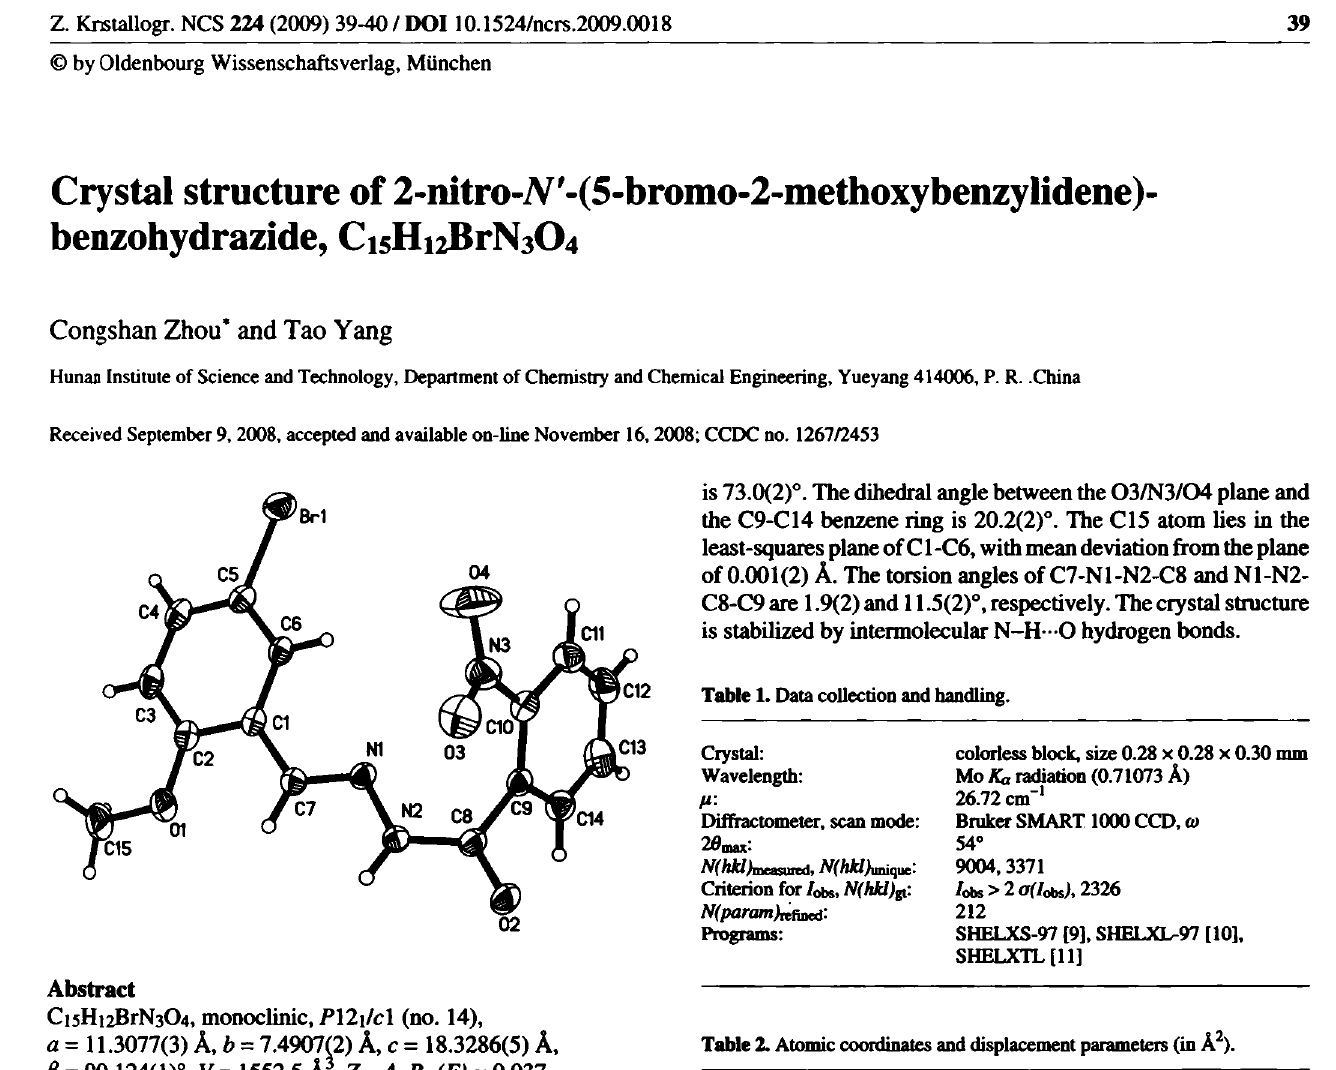
Table 2. Atomic coordinates and displacement parameters (in Â 2